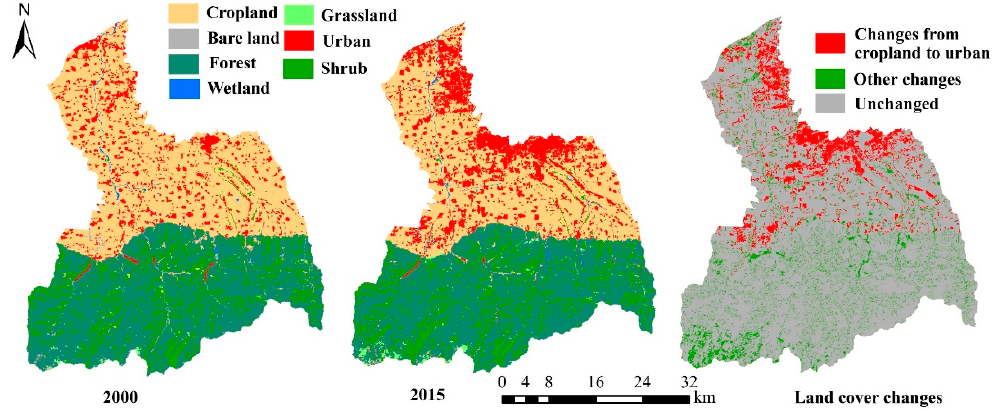
Figure 2. Spatial distributions and changes of land cover in the FRW from 2000 and 2015.